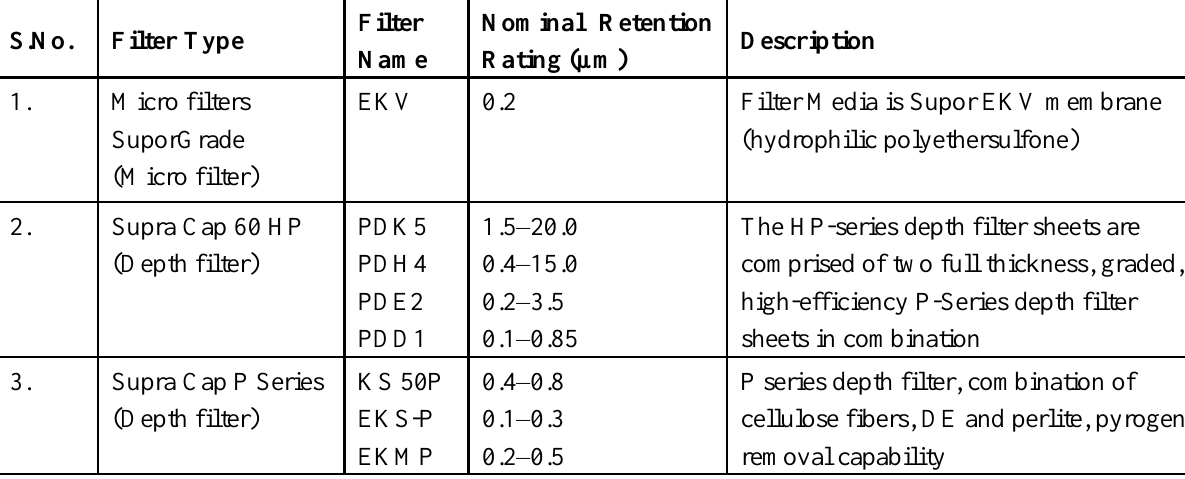
Table 1. Different types of micro filters and depth filters used in the investigation.